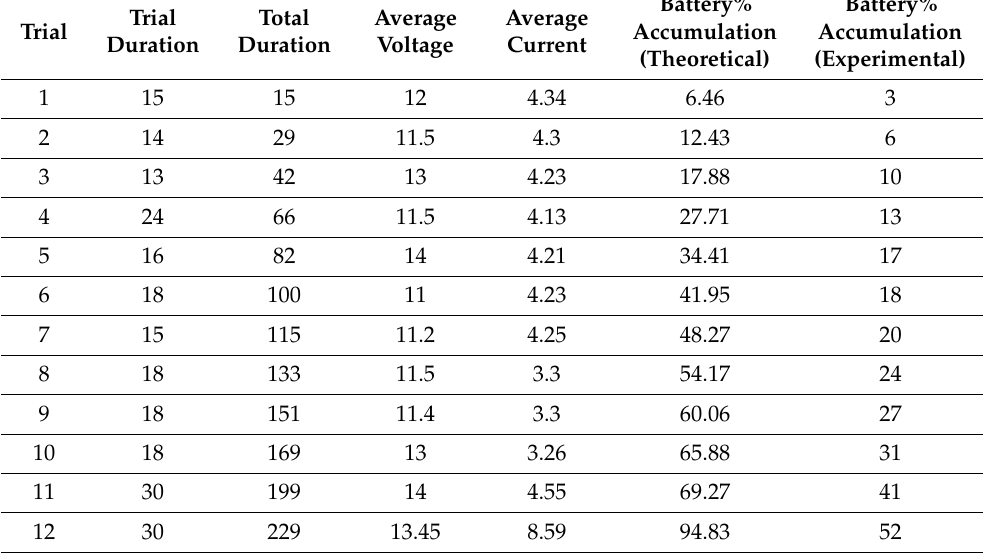
experimental data.